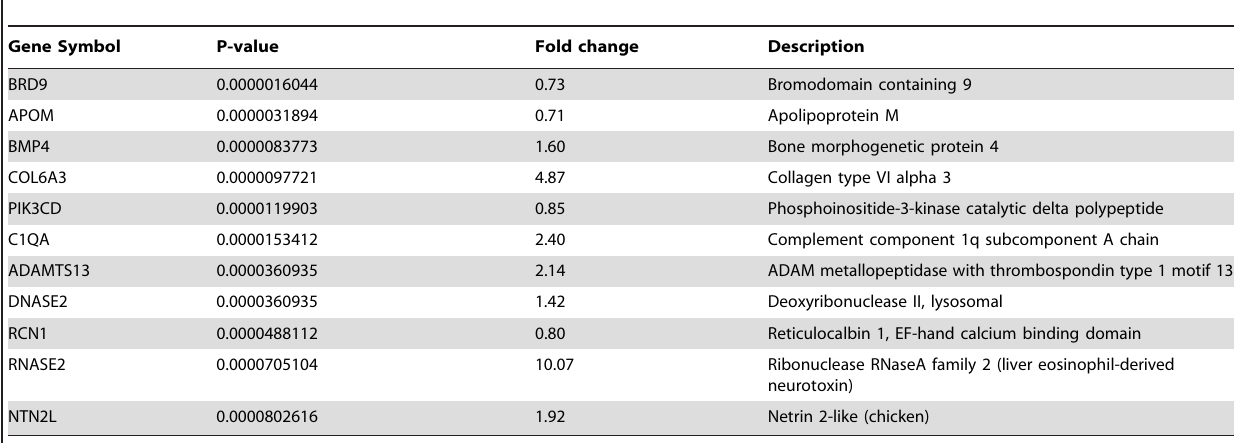
Table 2. Candidate proteins identified from the secreted protein